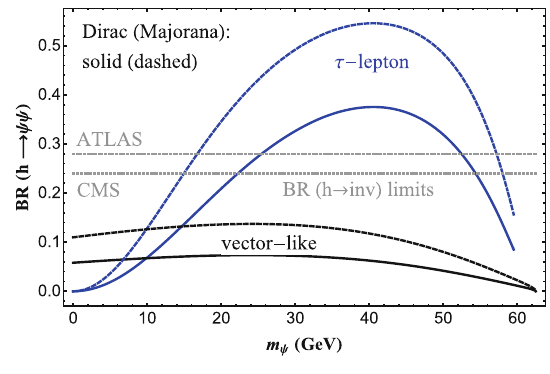
Fig. 7 Branching ratios of the Z and the Higgs bosons decaying invis- ibly into DM (Dirac in solid, Majorana in dashed). We show in black the case of vector-like fermions in the loop, in red the case of a tau-lepton